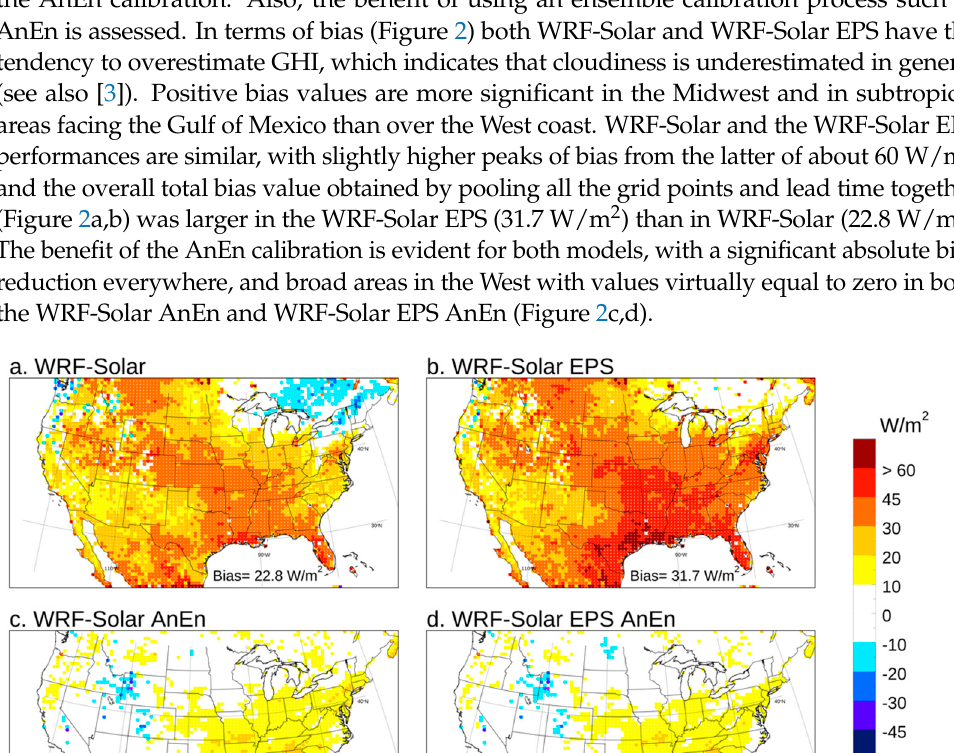
Figure 3. Root mean squared error (RMSE) computed for GHI over the year 2018 for the forecast lead times from +24 to +48 h. The value in the legend at the bottom of each panel indicates the RMSE computed by pooling all the grid points and lead times together.